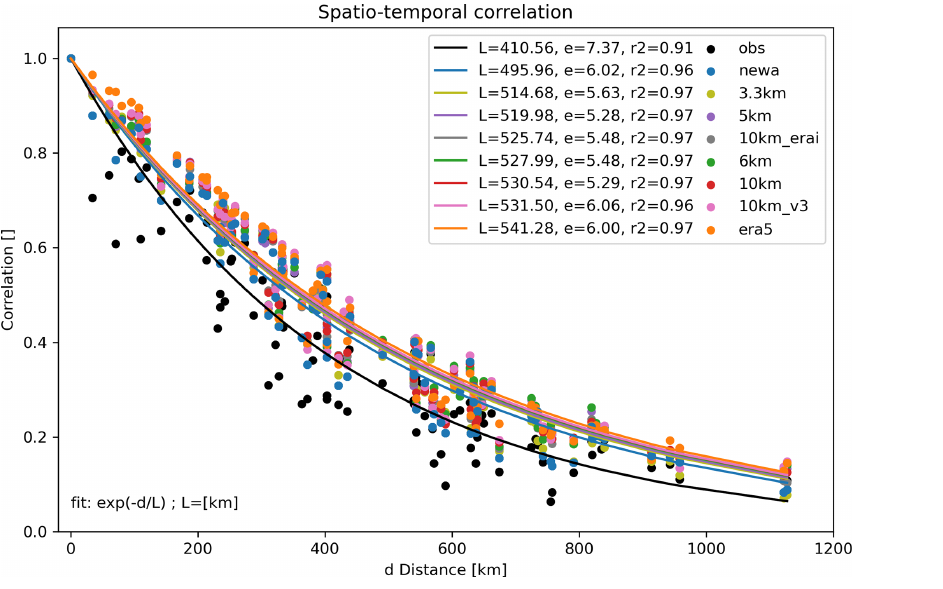
Figure 8. Correlation versus distance for each pair of sites (Table 2) and the fitted curves for the measurements (black) and the various model simulations in Table 1 and reanalyses. The estimated de-correlation length L is also shown for each simulation.